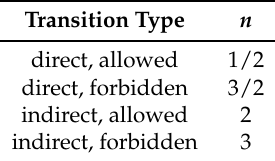
Table 3. Types of electronic dipole transitions and their corresponding exponent n to be used in Equations (4)–(6) [104–109].